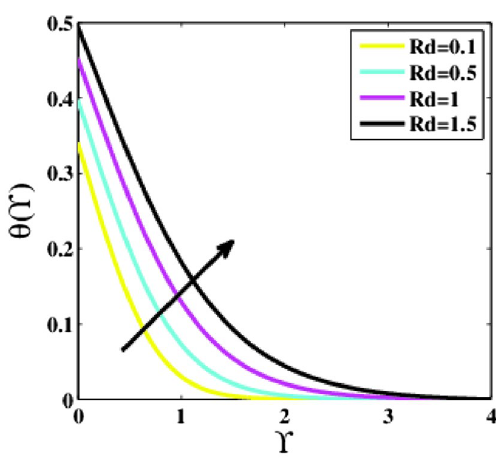
Figure 15. Plots of θ(ϒ) for Rd